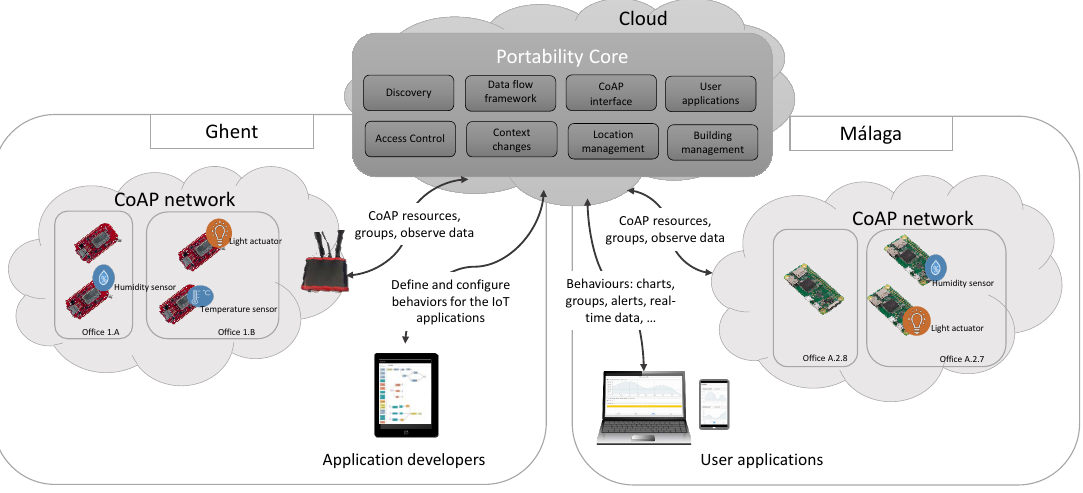
Figure 3. Architecture of the